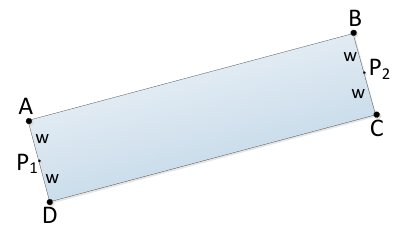
Figure 3. Definition of the basic road segment by rectangle The population is built up of these rectangles. During the initialization 50-100 rectangles were generated with random coordinates for points P 1 and P 2 , where the width parameter w was fixed. The rectangles are masks laid on the binary segmentation image. The fitness function can be defined for this binary subimage, as follows  counting the covered road pixels,  based on the number of the covered road pixels divided by the length/area of the